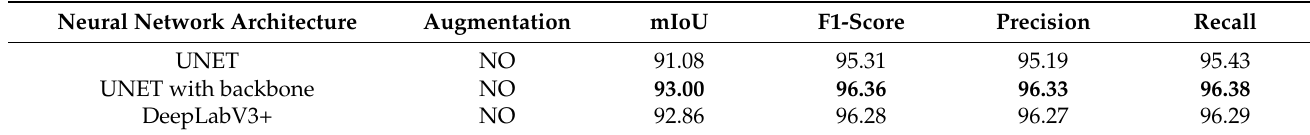
Table 4. Results for 0.1 m dataset